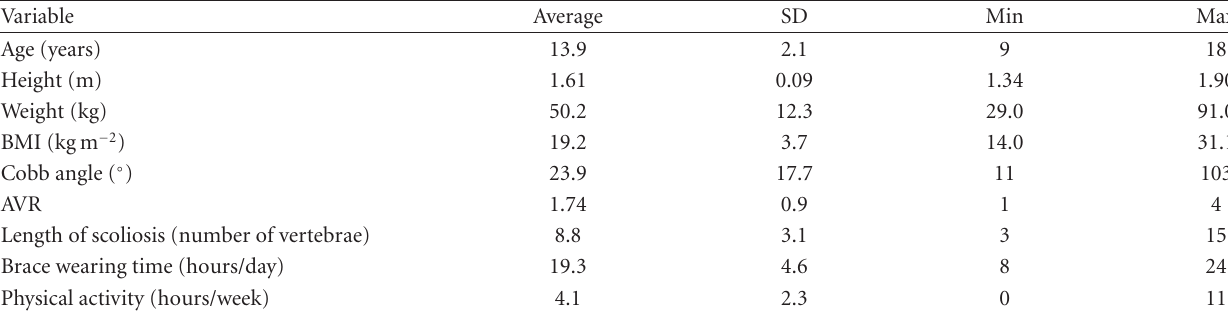
Table 1: The characteristics of the study group ( n =